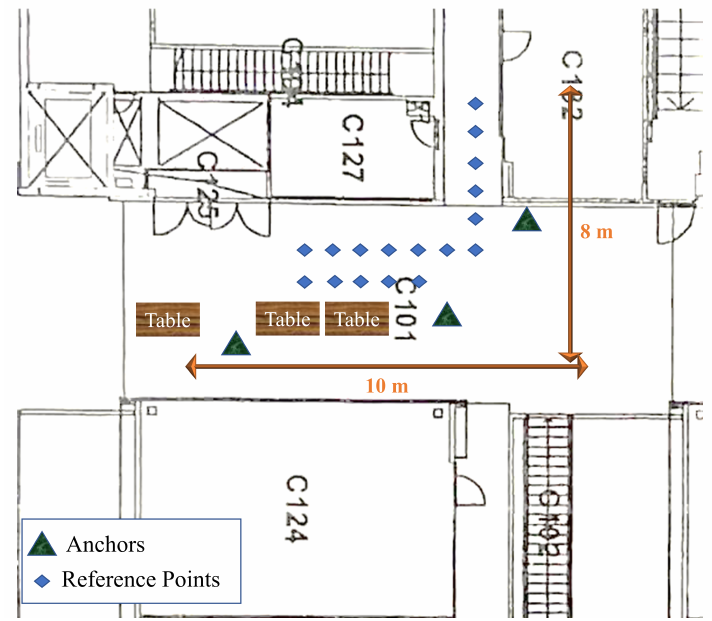
Figure 10. Floor plan of the area of measurement